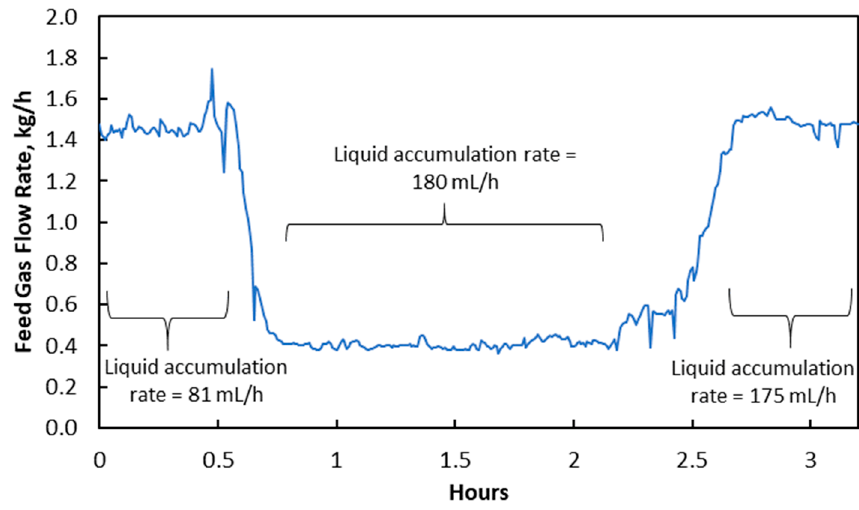
Figure 3. Changes in feed gas flow rate and its impact on liquid accumulation rate in treated gas knock-out drum. Table 4. Changes in the degree of membrane wetting when feed gas flow rate was reduced.